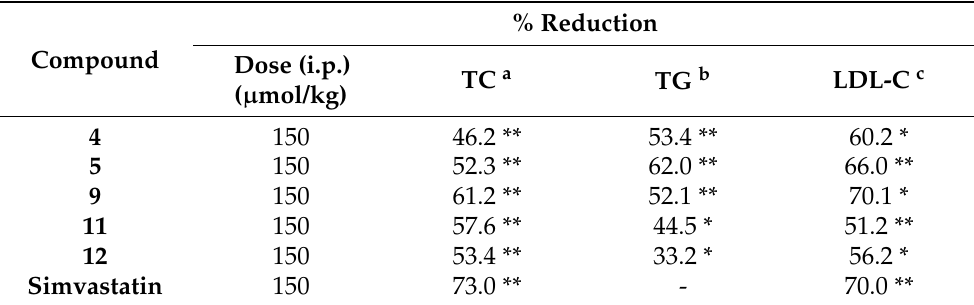
Table 5. Effect of compounds 4 , 5 , 9 , 11 , 12 and simvastatin on Triton WR1339 (tyloxapol)-induced